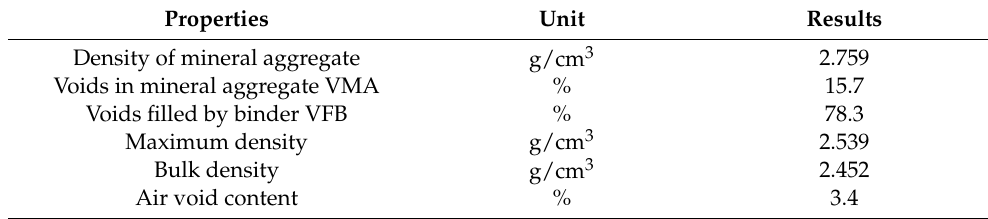
Table 2. Volumetric properties of the asphalt mixture.